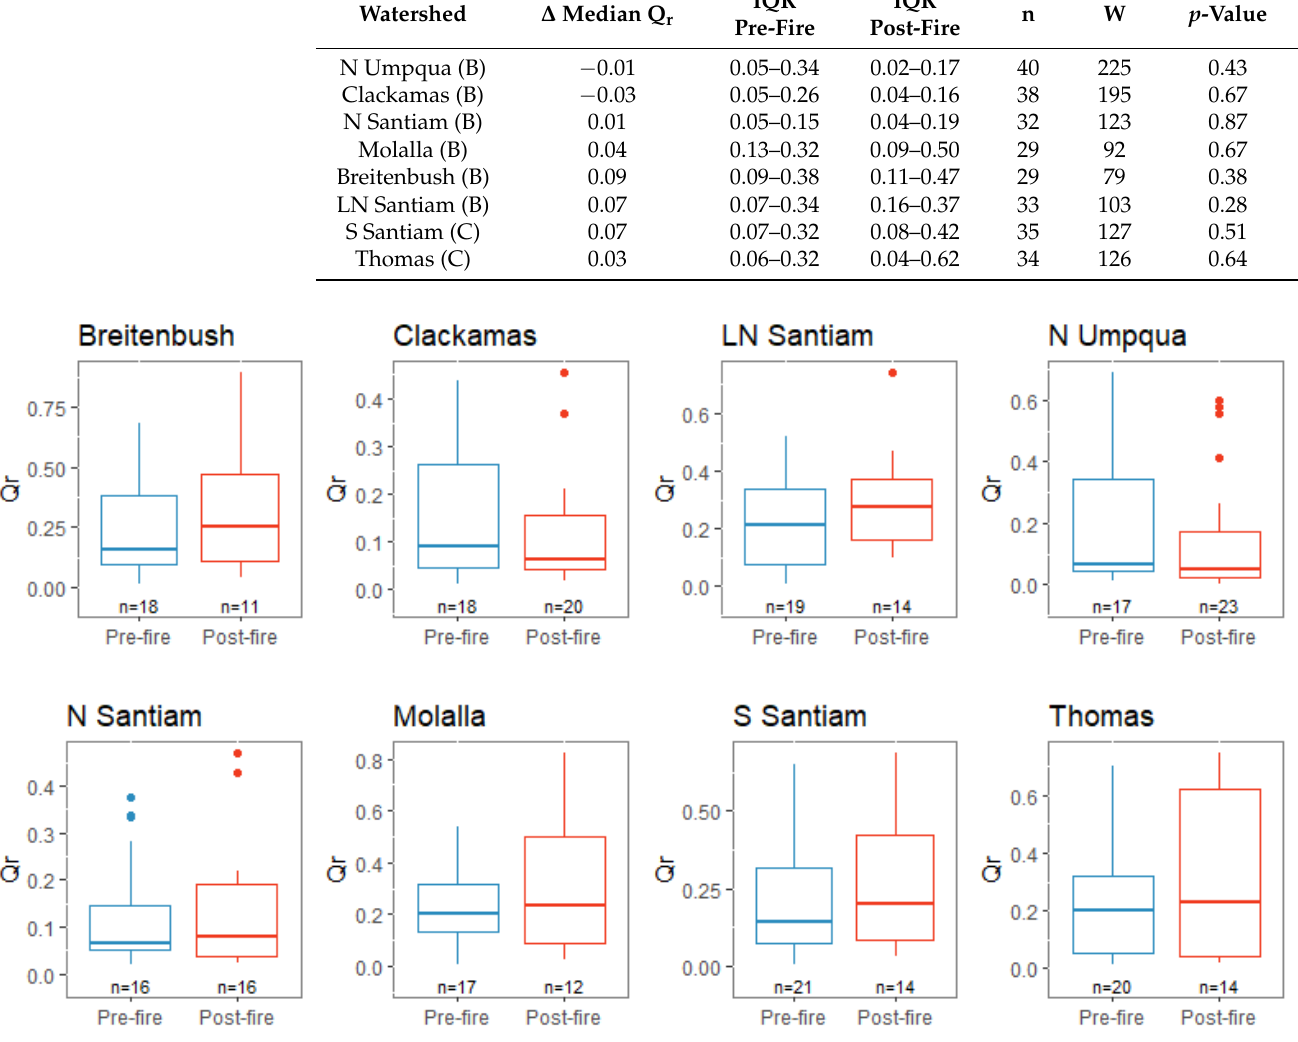
Figure 4. Box whisker plots of Q r values and for pre-fire and post-fire periods for eight Oregon Cascade watersheds.